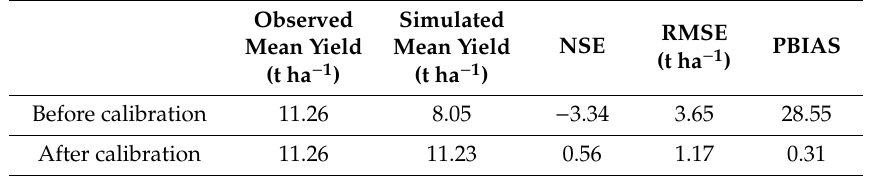
Figure 5. Linear regression of simulated crop yields in tonnes per hectare (t ha − 1 ) on observed maize yields with the calibrated maize crop file. Table 4. Model evaluation statistics before and after calibration showing Nash–Sutcliffe efficiency